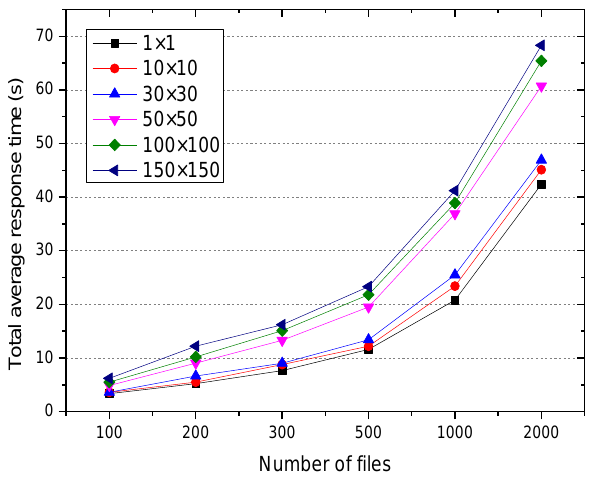
Figure 5. Total average response time.